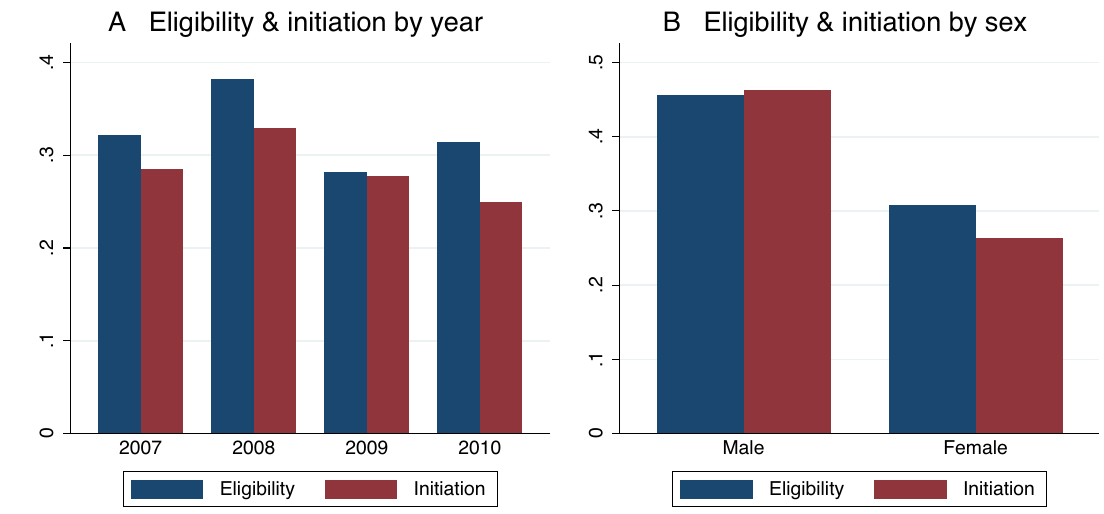
Figure 2. Share of individuals becoming eligible and starting treatment by year and